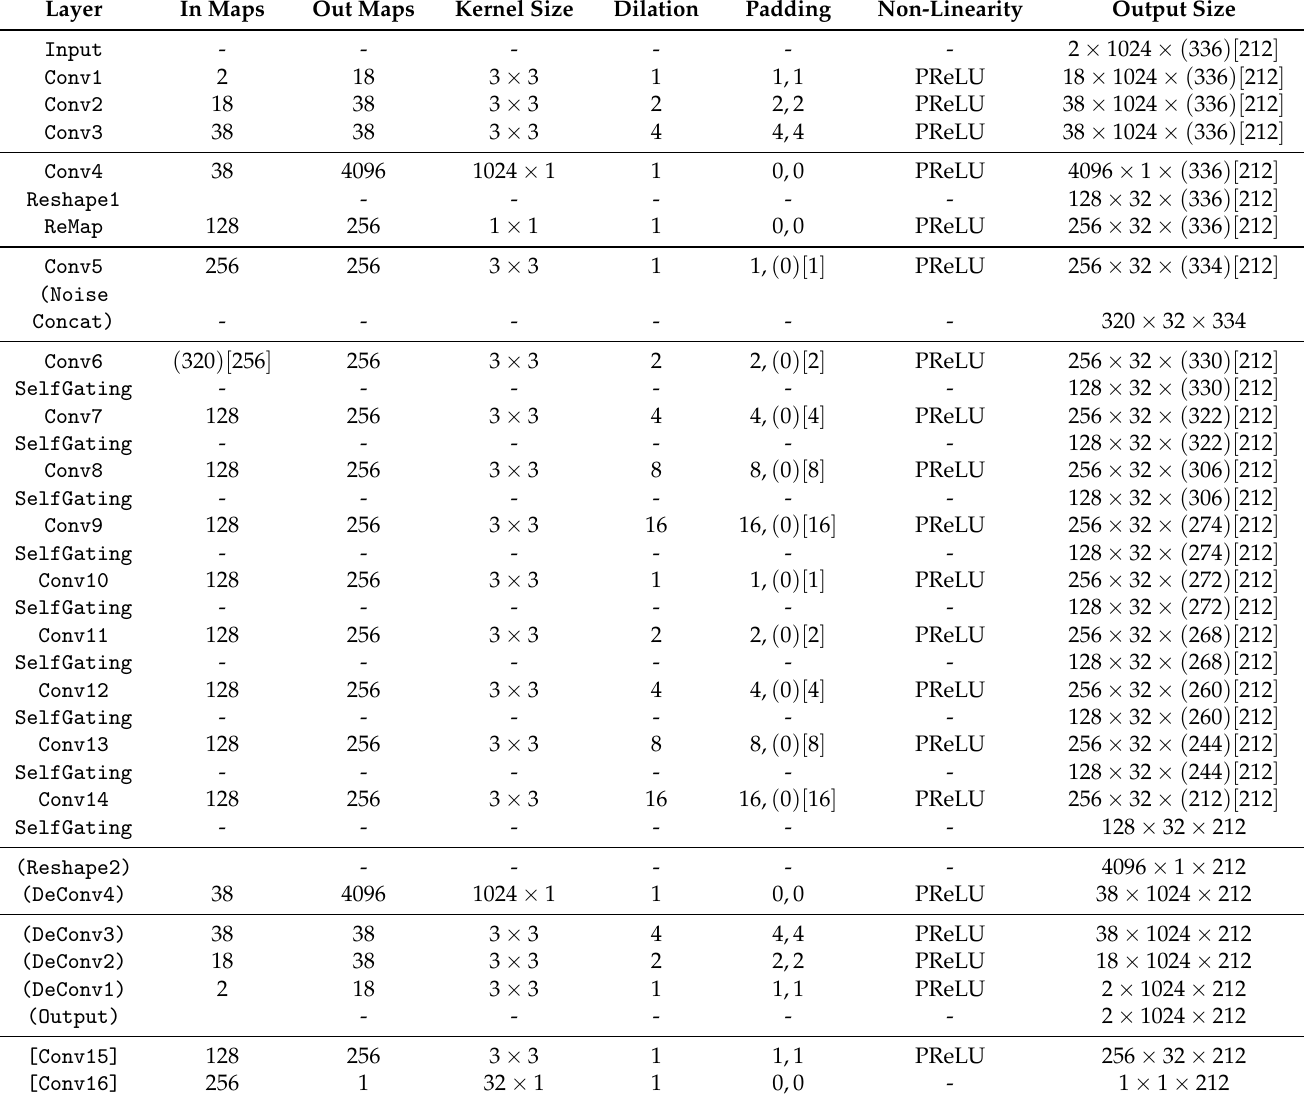
Table 1. Architecture details of generator G and critic D for four-second-long excerpts (i.e., 336 spectrogram frames), where ( · ) -brackets mark information applying only to G , and information in [ · ] -brackets applies only to D . During training, no padding is used in the time dimension for G , resulting in a shrinking of its output to 212 time-steps. Layer In